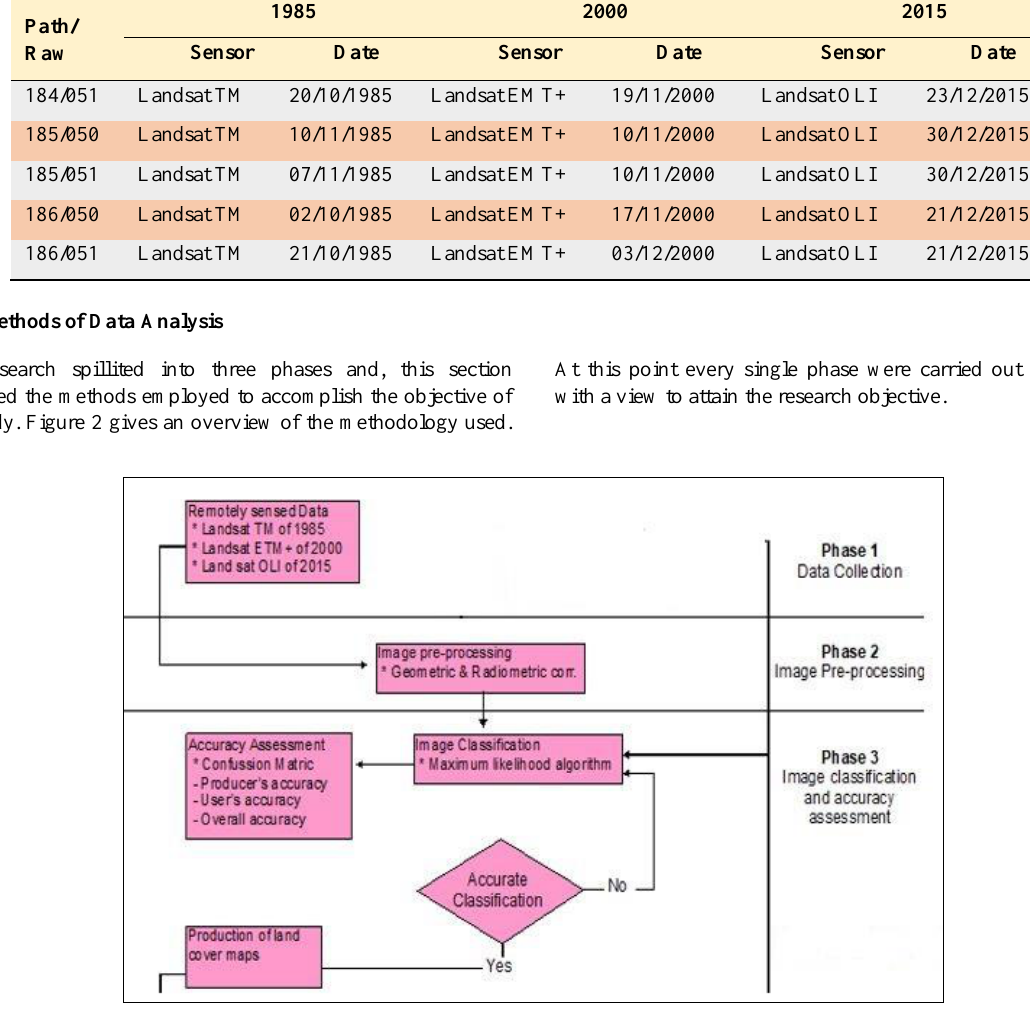
Figure 2. The methodology